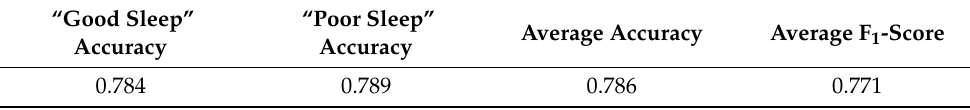
Table 6. The performance of sleep quality evaluation